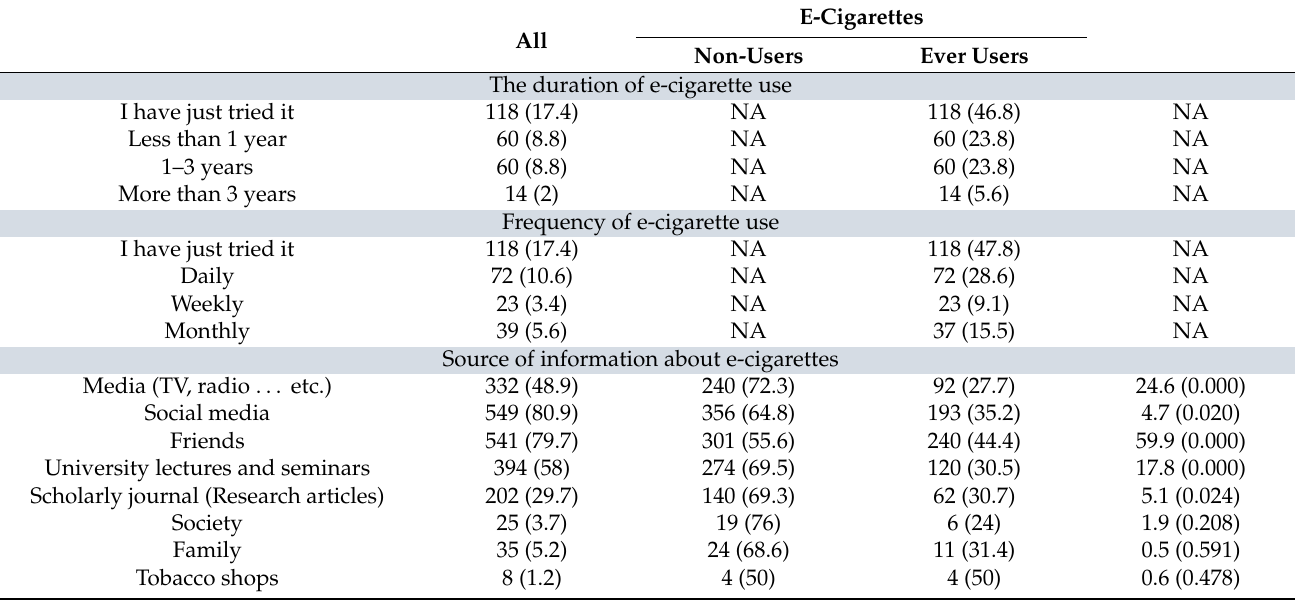
Table 3. Frequency and Duration of E-cigarette Use and Source of Information about E-cigarettes as Reported by Study Sample, N = 679. E-Cigarettes Non-Users Ever